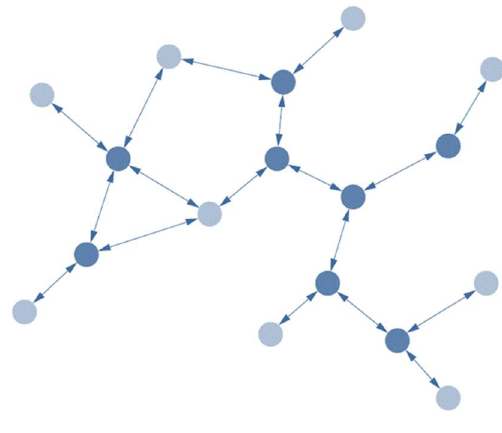
Figure 1. The backbone illustration